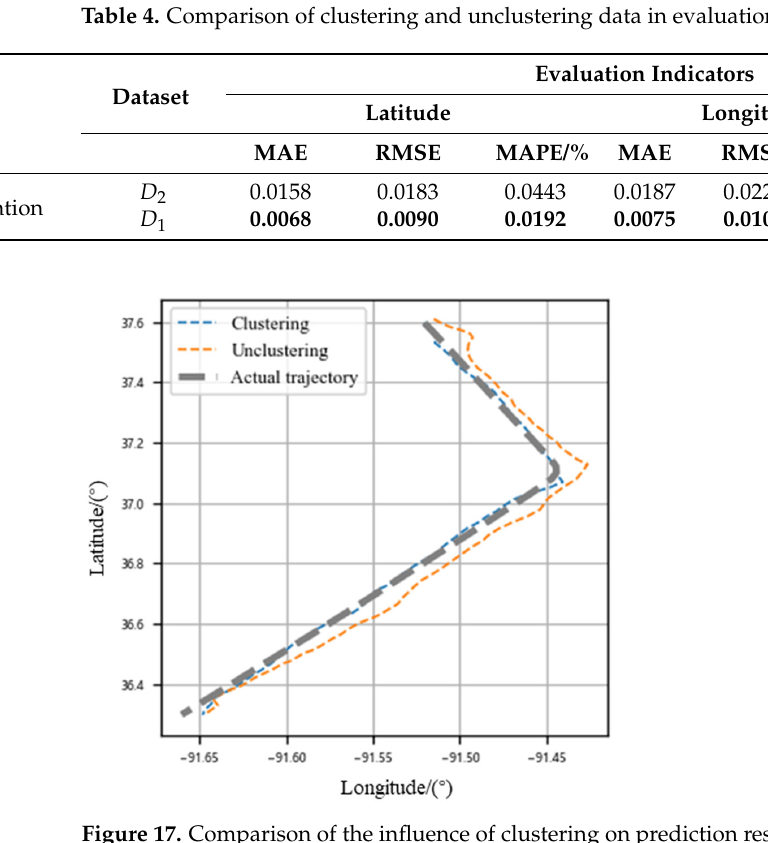
Figure 17. Comparison of the influence of clustering on prediction results.